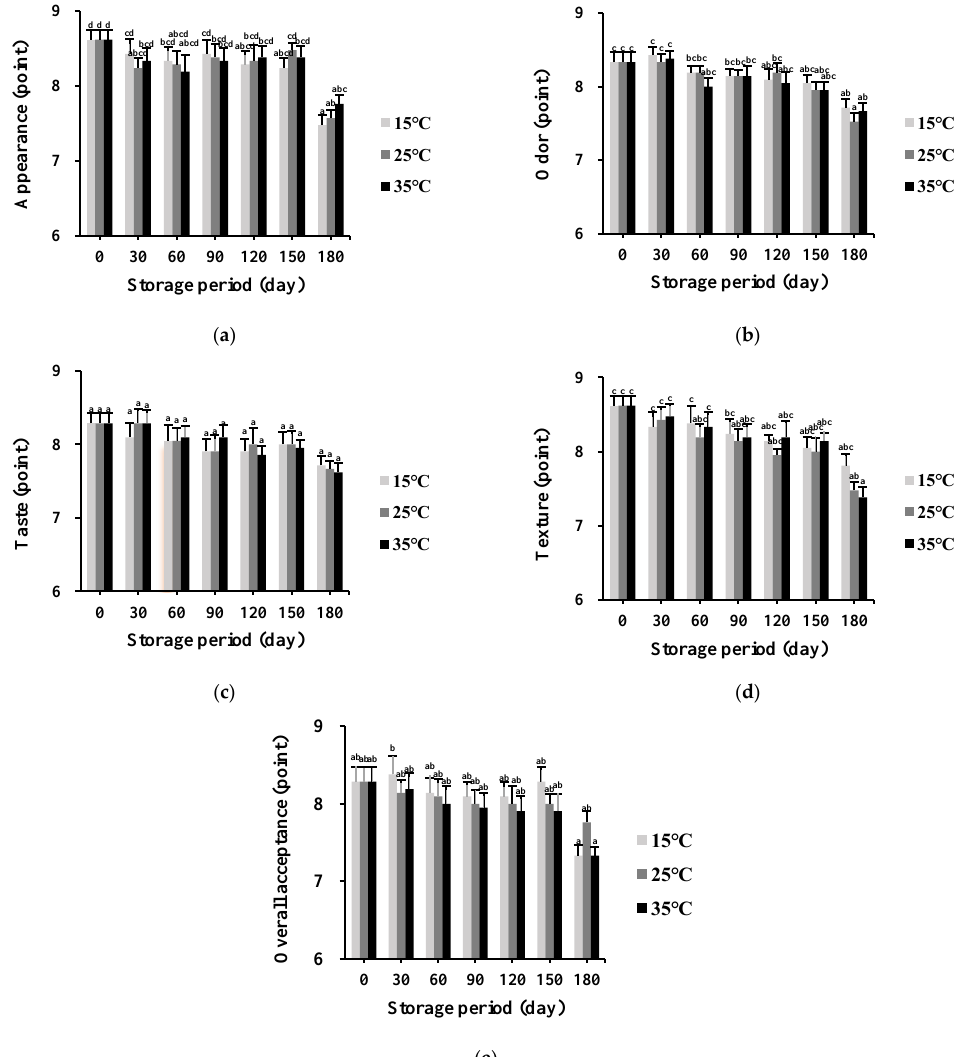
Figure 7. Changes in sensory evaluation of the puffed-rice snack enriched with drone pupae powder at different storage temperatures (15 °C, 25 °C, and 35 °C) for 180 days: ( a ) Appearance; ( b ) Odor; ( c ) Taste; ( d ) Texture; ( e ) Overall acceptance. The values are mean ± SD. Different letters (a – c) in the columns indicate significant differences among the means by the Tukey’s test ( p < 0.05).